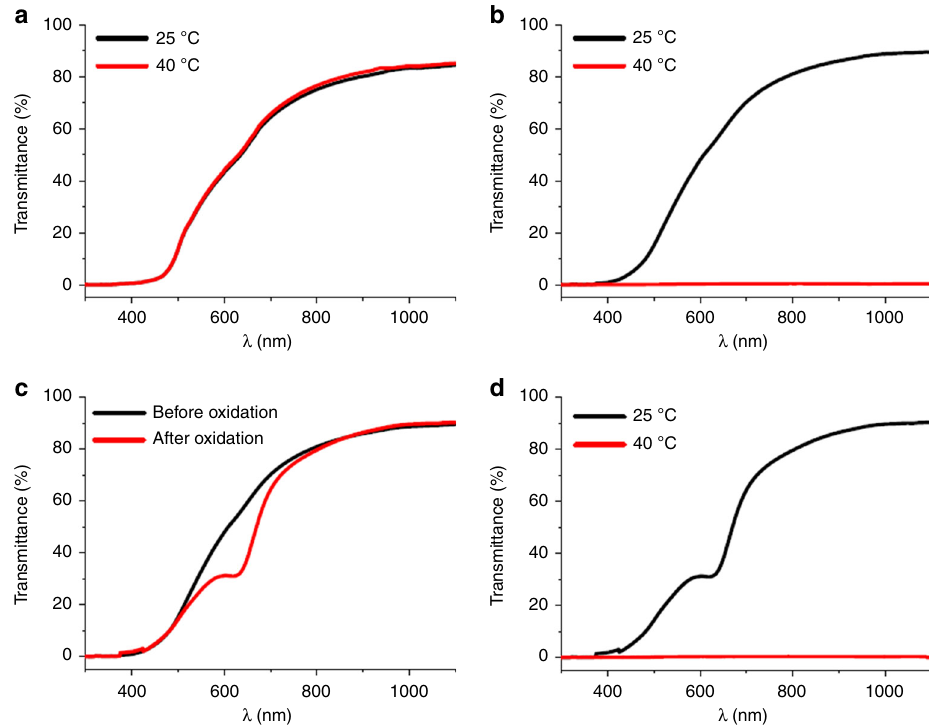
Fig. 6 Transmittance changes under different conditions. Transmittance changes of a Fc-gel immersed in pure water; b Fc-gel ∙ EGP6 hydrogel; d oxidized Fc-gel ∙ EGP6 hydrogel at 25 and 40 °C; c Fc-gel·EGP6 hydrogel before and after